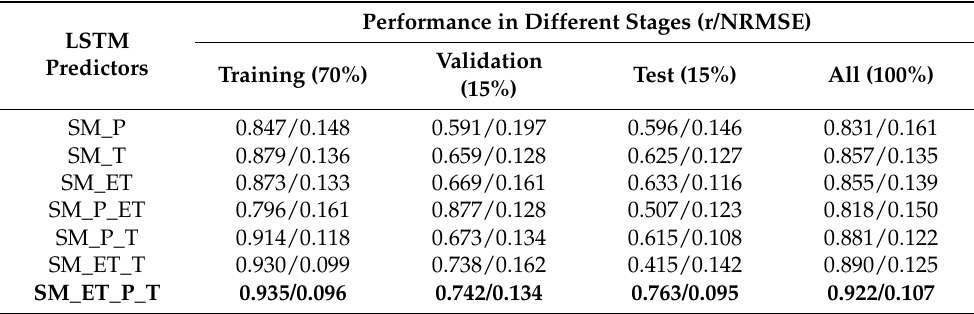
Table 3. Comparison Between LSTM-Generated TWSA and GRACE-Generated TWSA (2003– 2012).